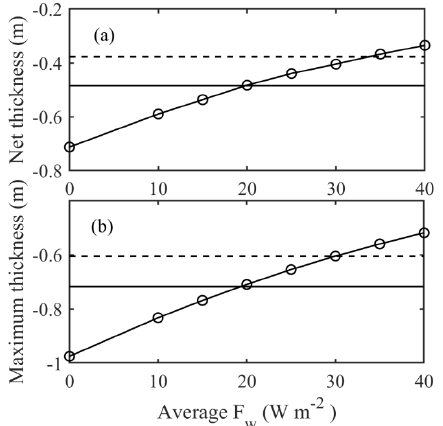
Figure 8. Modeled (lines with circles) average (a) and maximum (b) ice thickness applying the different constant F w . The broken lines are observed average and maximum ice thickness during the simulation period. The solid lines are observed average and maxi- mum ice growth at the ice bottom.